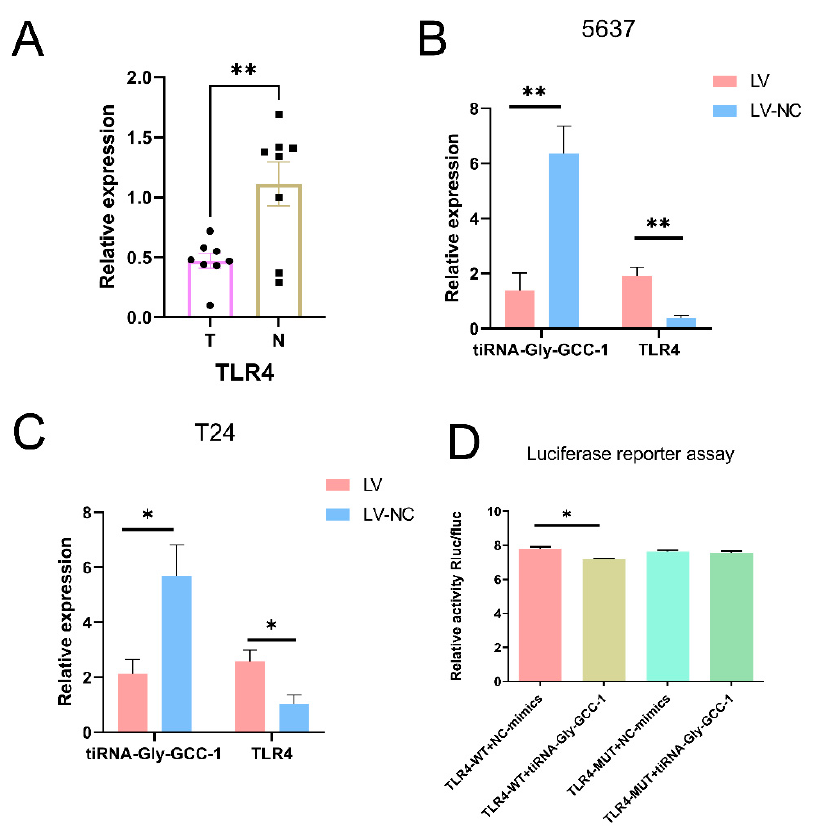
Figure 7. The relationship between tiRNA-Gly-GCC-1 and TLR4 (transfection group, LV; negative control group, LV-NC; tumor group, T; paracancerous tissues group, N). The data were normalized using the mean ± SEM. ( A ) The relative expression of TLR4 in UBC and paracancerous tissues. ( B ) The relative expression of two genes in LV and LV-NC group in 5637 cells. ( C ) The relative expression of two genes in LV and LV-NC group in T24 cells. ( D ) The luciferase assay for tiRNA-Gly-GCC-1 and TLR4. * indicates p -value < 0.05. ** indicates p -value < 0.01.